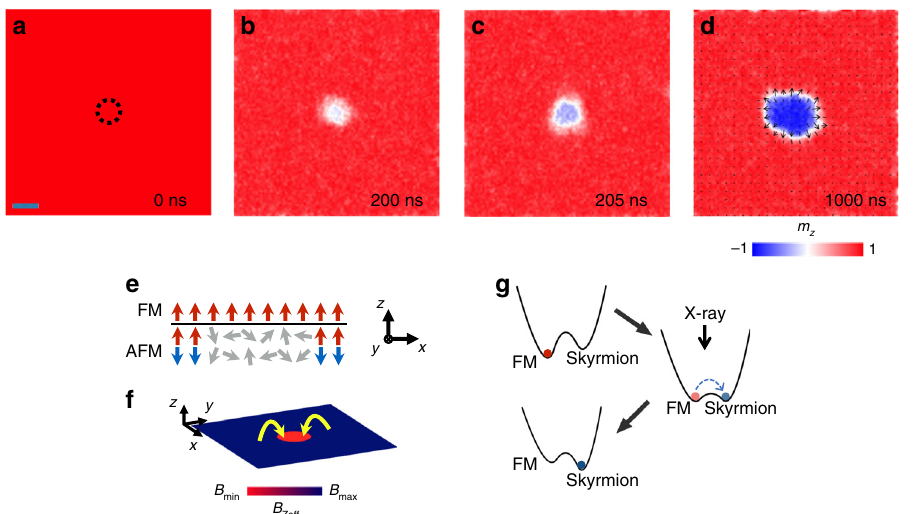
Fig. 4 Simulation of the X-ray-induced single skyrmion creation. a – d Snapshots of the single skyrmion creation process in the x – y plane. The color represents the averaged m z across all the magnetic layers. The X-ray illumination within the region enclosed by the dashed line is simulated by turning off the perpendicular external fi eld therein. The spin texture of the created skyrmion is also illustrated in d , where the color represents the out-of-plane magnetization and the arrows represent the local magnetization direction. The scale bar in a is 44 nm. e Schematic of the magnetization in both the ferromagnetic and antiferromagnetic layers during the illumination process. f Calculated z -component of the effective fi eld during the illumination (before the skyrmion creation happens). The red circle is the X-ray illumination region. The yellow arrows schematically indicate the in fl uence of the effective fi eld. g The schematic energy landscape of the ferromagnetic state and skyrmion state before, during, and after the X-ray illumination. The energies were calculated via micromagnetic simulations.